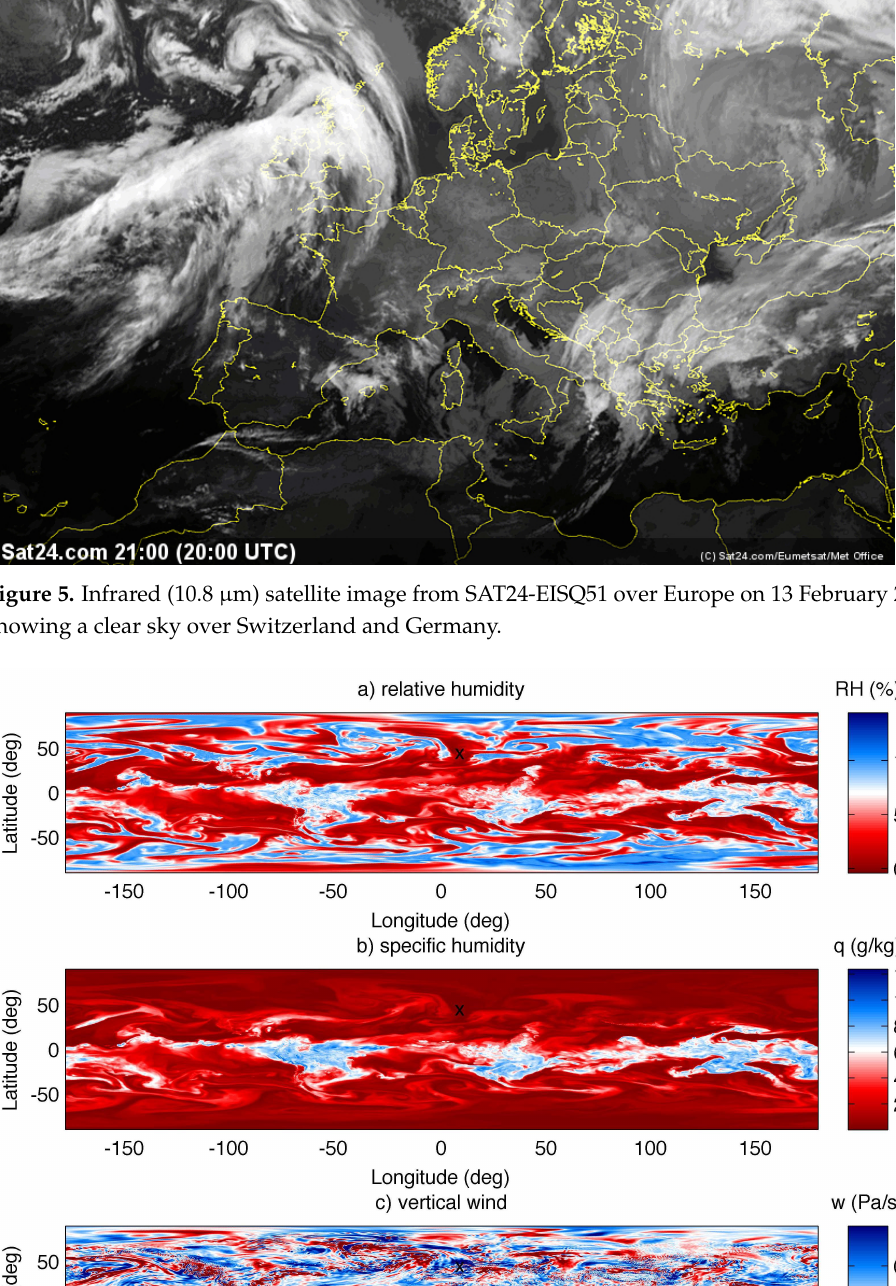
during the time of IWV depression (13 February 2021, 20:00 UT). The NOAA